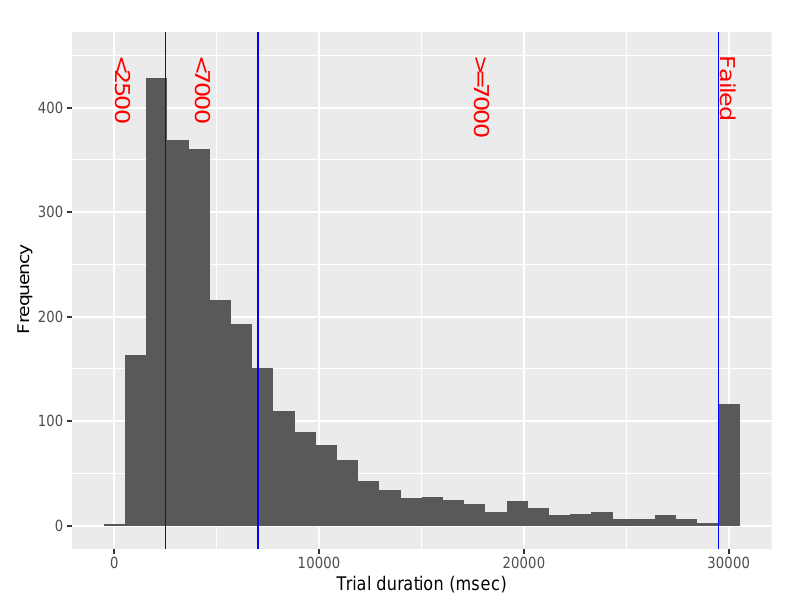
Figure A3. Frequency of trial durations. The blue vertical lines delimit the non-overlapping subgroups reported in Figure 6, and Appendices D and E. The first two subgroups divide the distribution at its mode, the third subgroup aggregates samples located at the tail of the distribution.